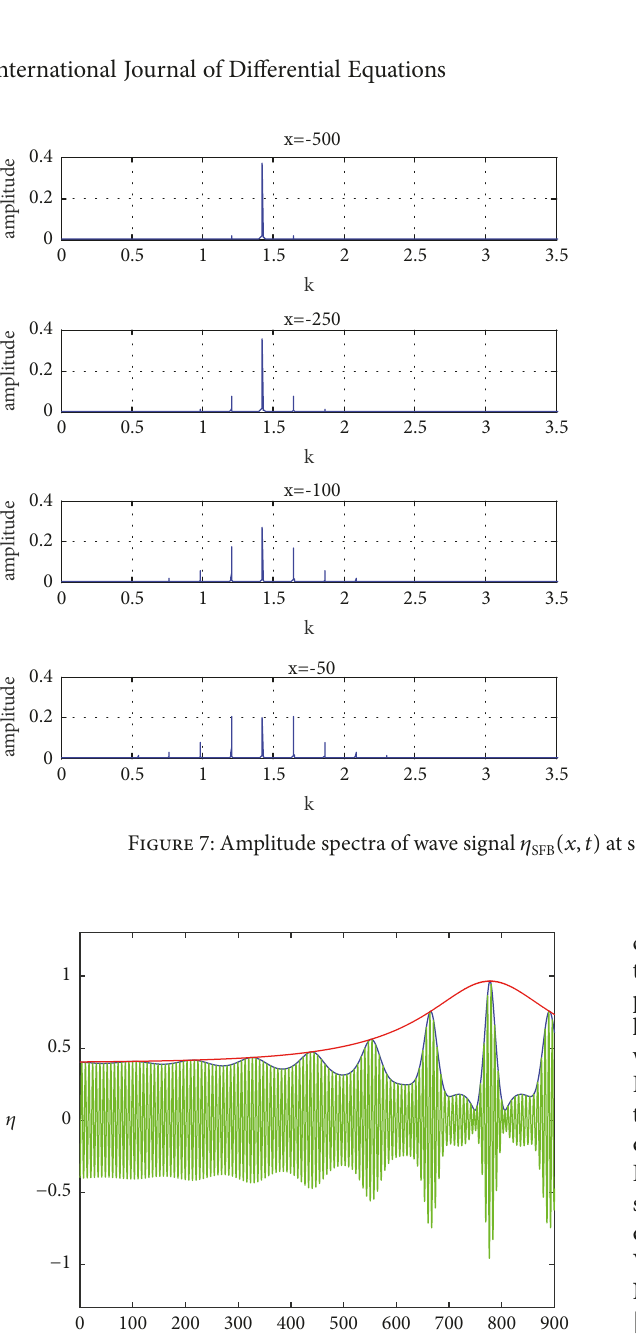
Figure 8: Elevation 𝜂 MTA (red) of the BBM wave packet for (̃𝑟 0